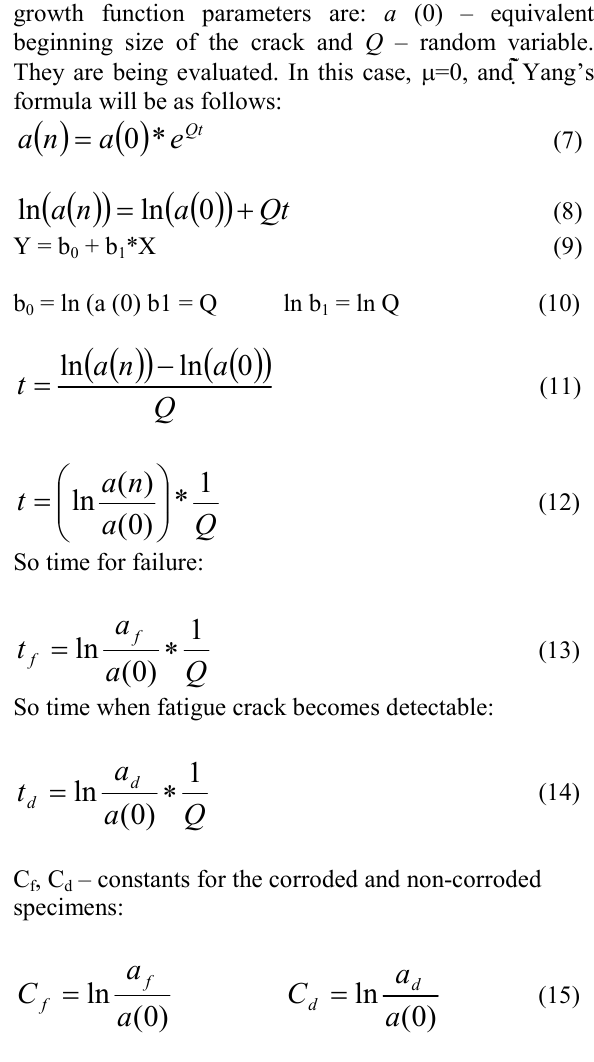
Table 3. Fatigue crack growth parameters for non-corroded